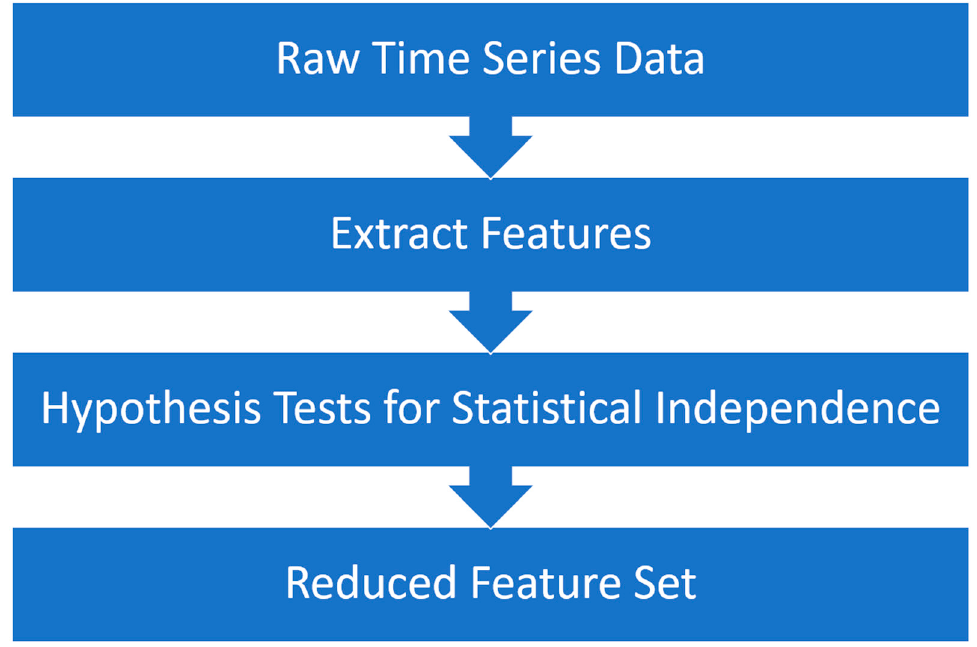
Figure 2. High-level TSFRESH process